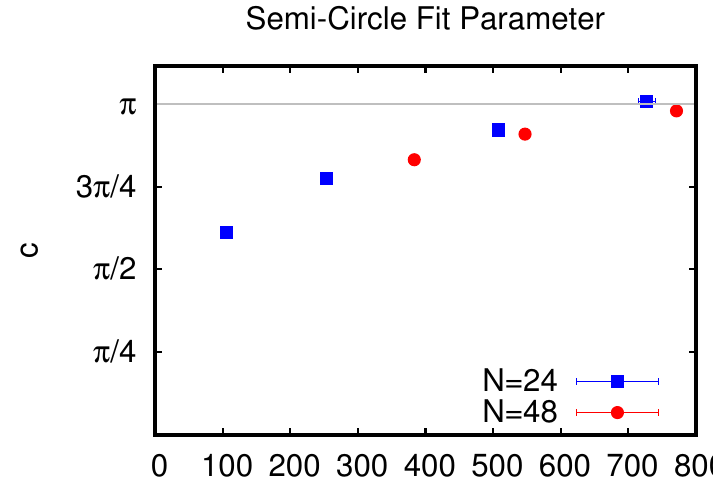
Figure 6 . The coe(cid:14)cient c obtained by (cid:12)tting the classical-statistical Wilson loop phase distribu- tions for various energies by the semi-circle distribution eq. (2.13) for N = 24 and N = 48 on 32 site lattice. Grey line is a guide to the eye. Results seem to suggest that c ! (cid:25) around E=N 2 ’ 750 (cid:6) 50 independent from N